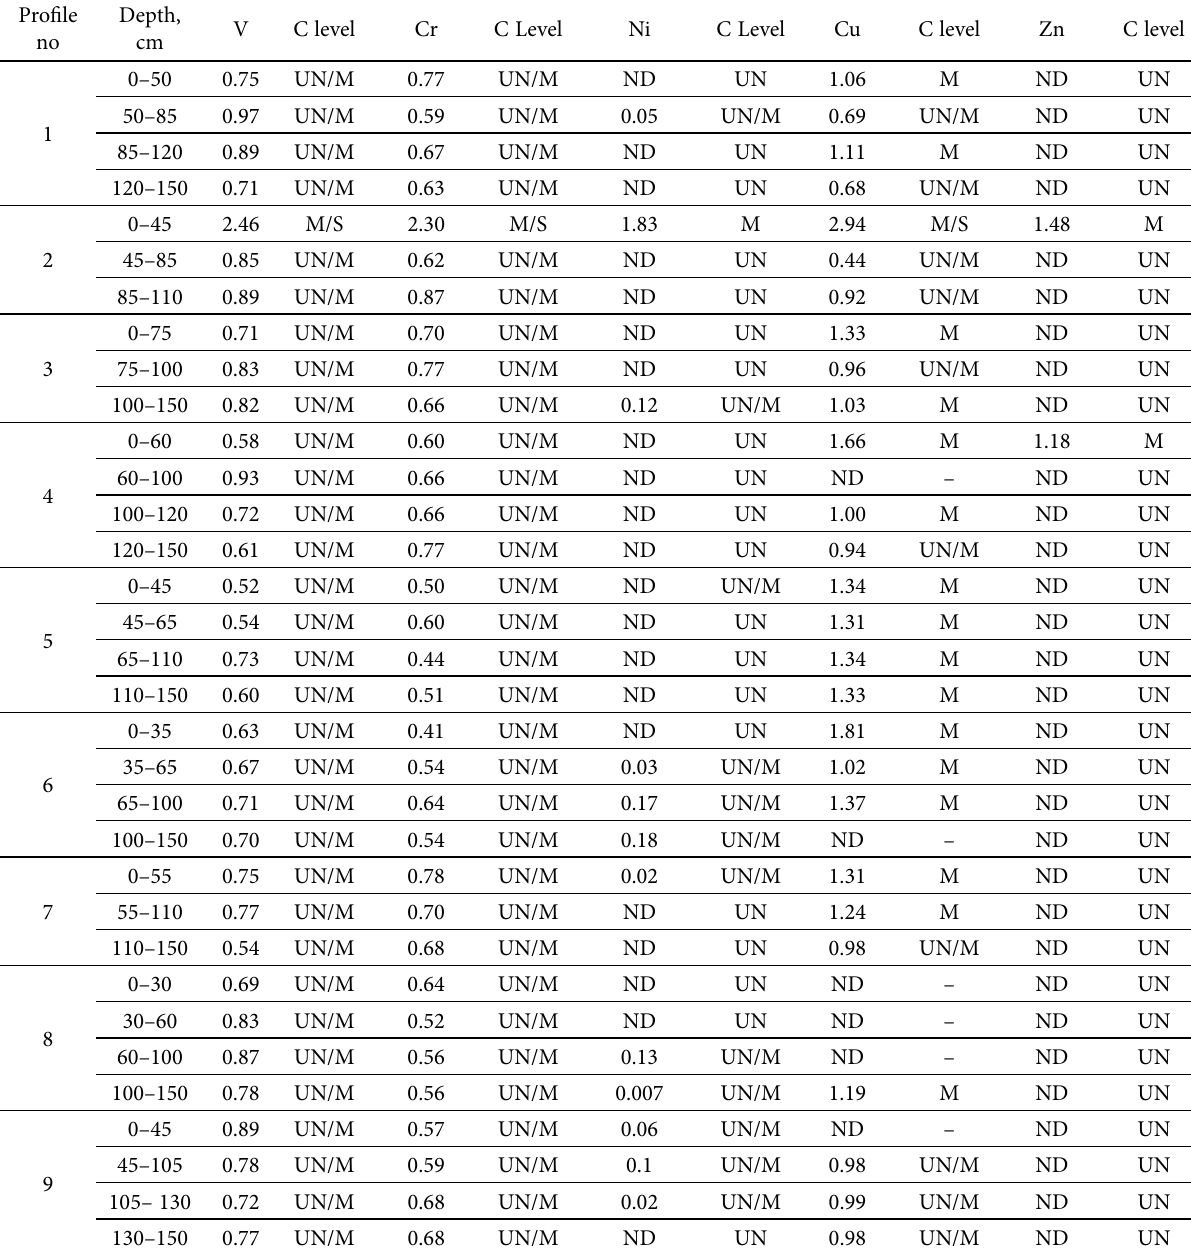
Table 6. Igeo Index concentrations and associated contamination levels